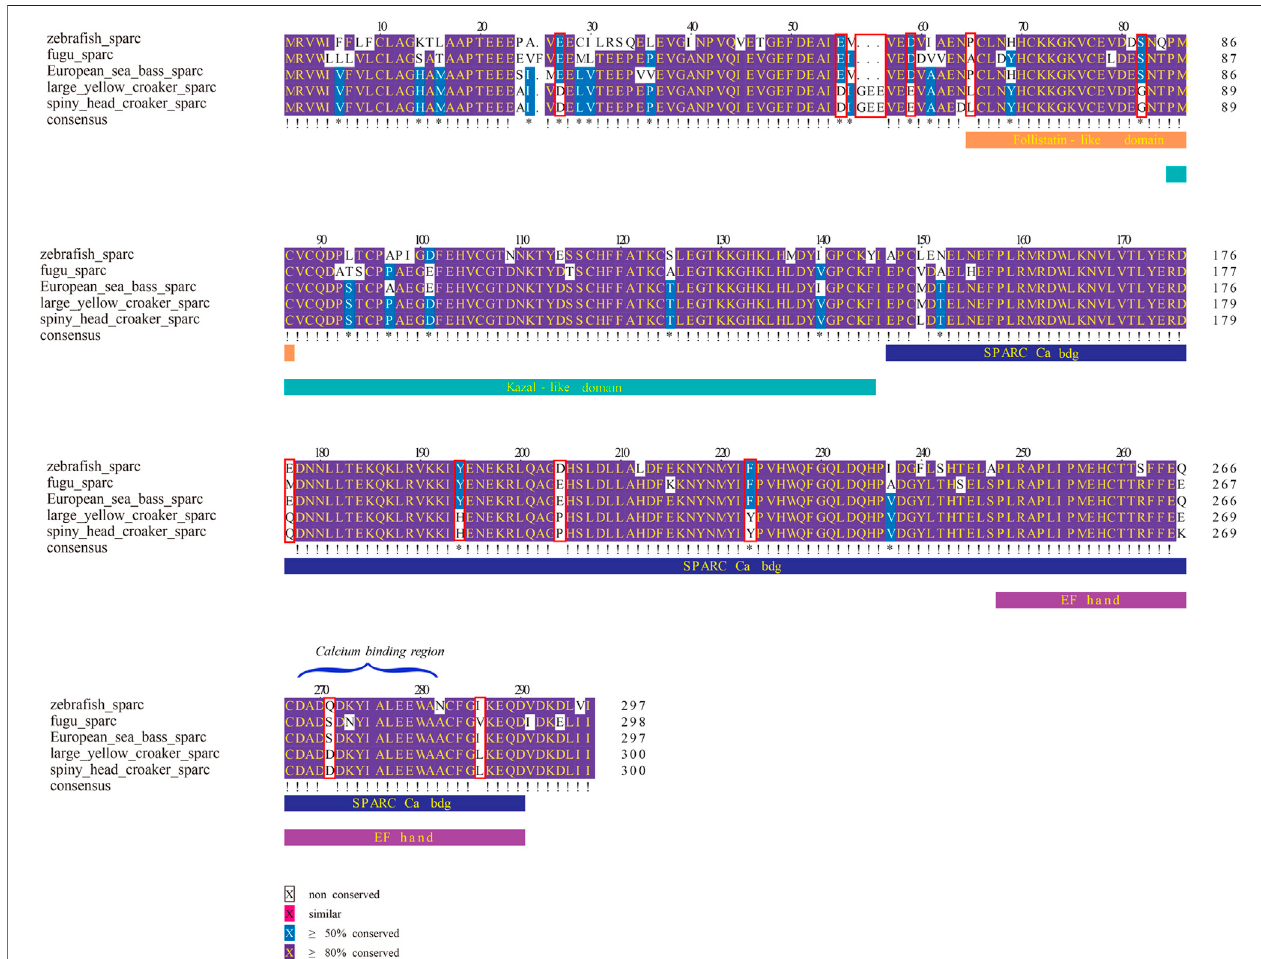
FIGURE 6 | Multiple alignments of partial SPARC sequences. Red boxes mark the changed amino residues in SPARC from the family Sciaenidae.